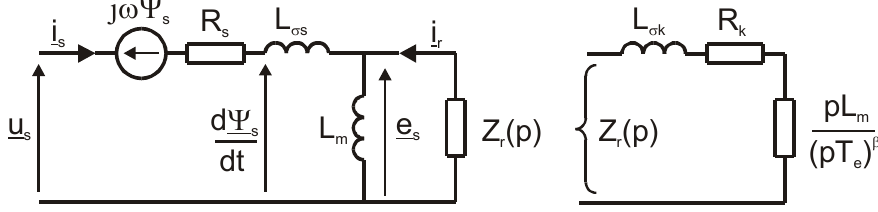
Figure 2. Equivalent circuit of an induction motor with fractional impedance.